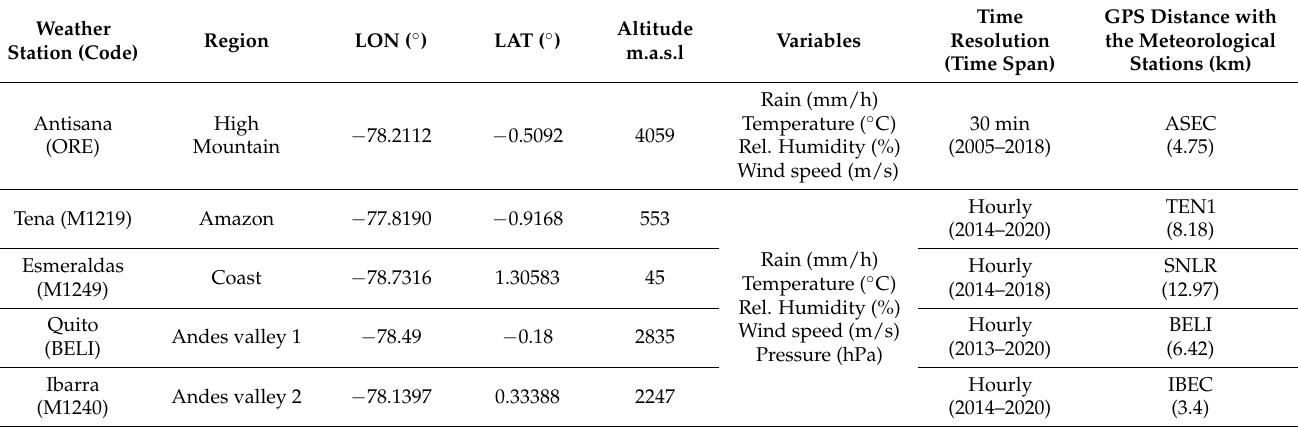
Table 1. Weather station coordinates, altitude, and distance to the nearest GPS station in kilometers.